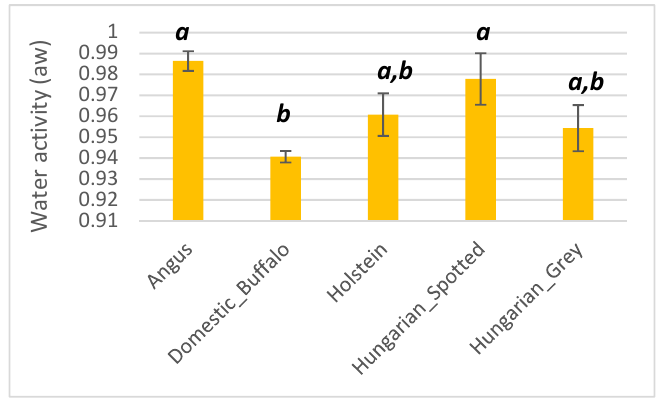
Figure 5. Bar plot showing the water activity of Angus, domestic buffalo, Holstein, Hungarian Spotted, and Hungarian Grey bovine breeds. Different superscripts imply significant differences.